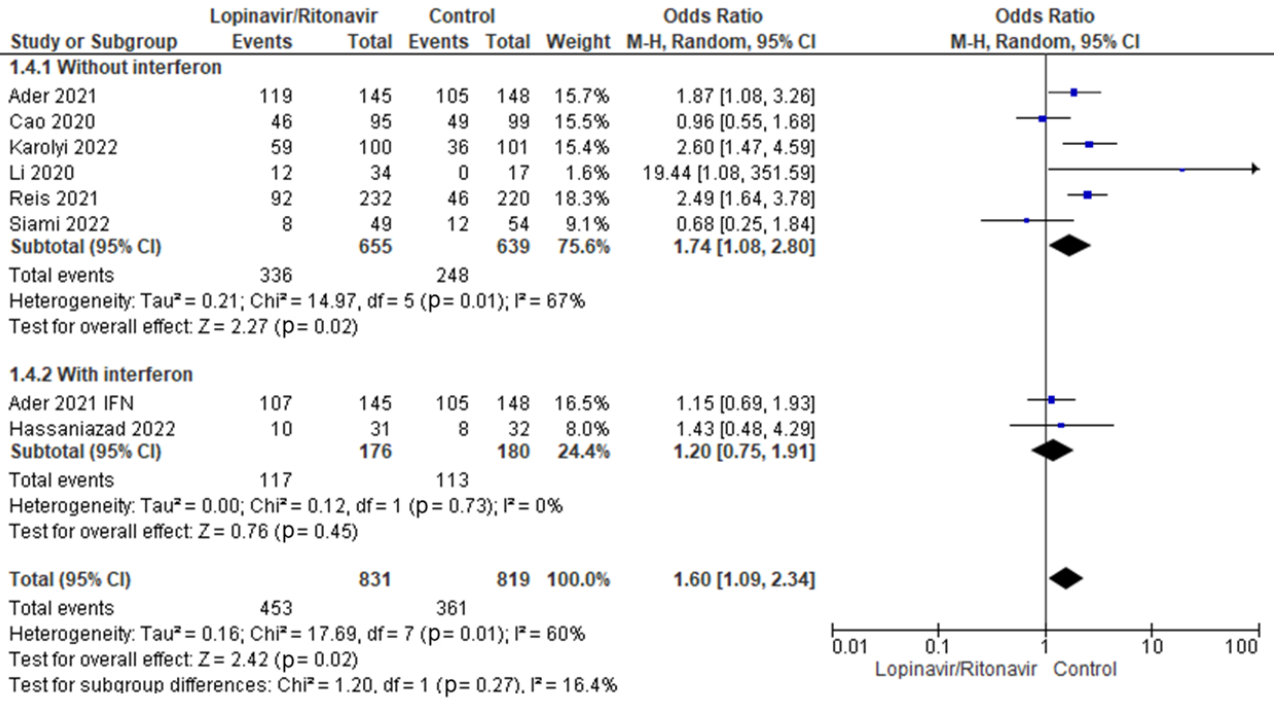
Figure 9. Subgroup analysis for adverse events. The sizes of the blue squares reflect the relative weight of the individual trials. The combined point estimates are shown as black diamonds. The diamonds and squares (together with the 95% CIs) located beyond the vertical line (indicating the unit value) show that a result was statistically significant.